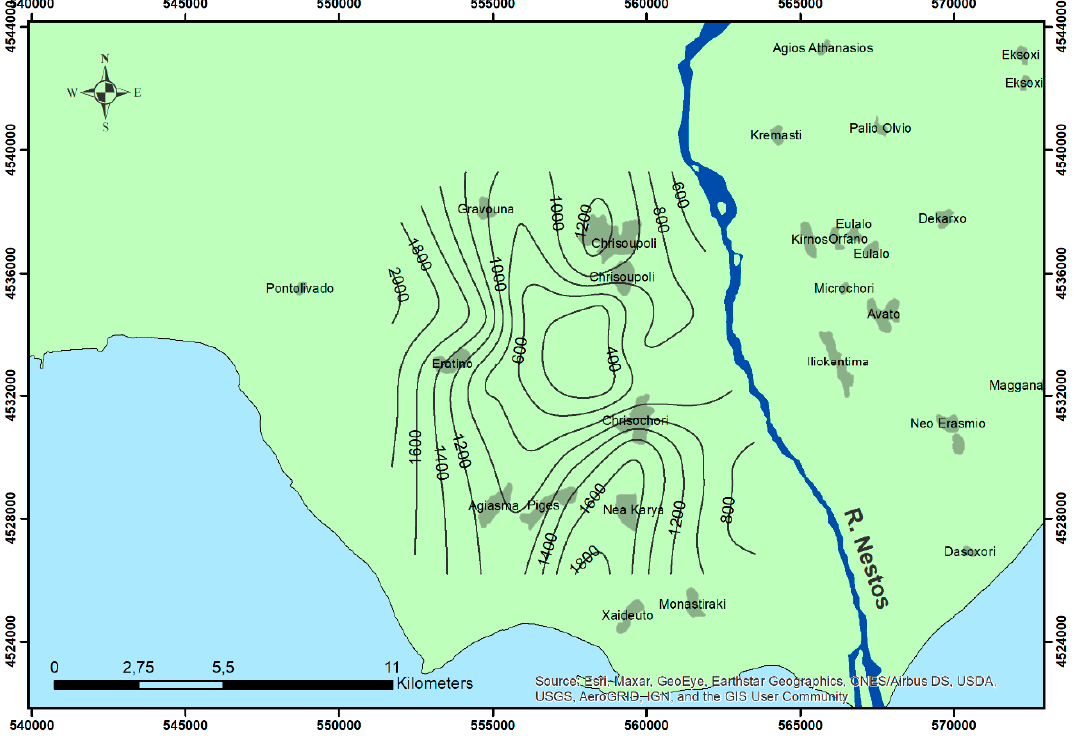
Figure 10. Electrical conductivity distribution map ( μ S/cm) of the unconfined aquifer (October 2019).